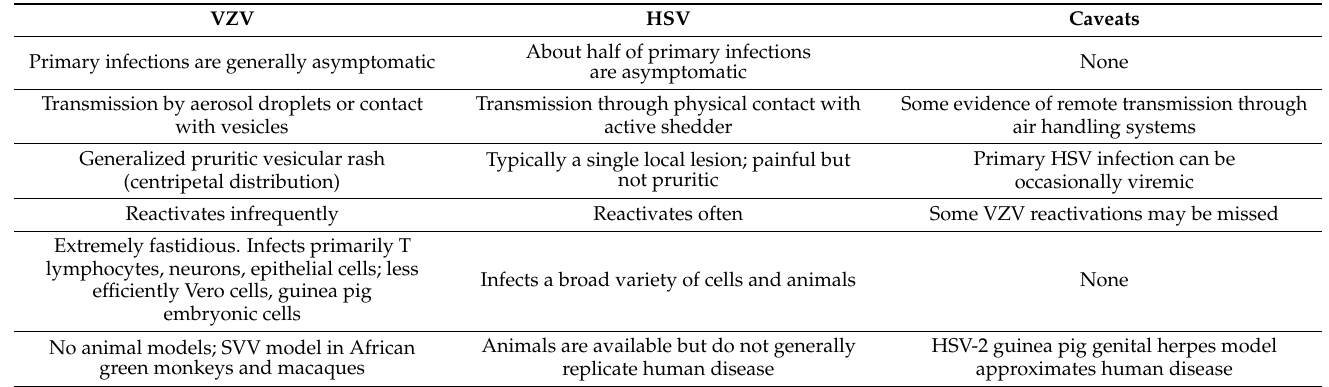
Table 1. Comparison of characteristics of VZV and